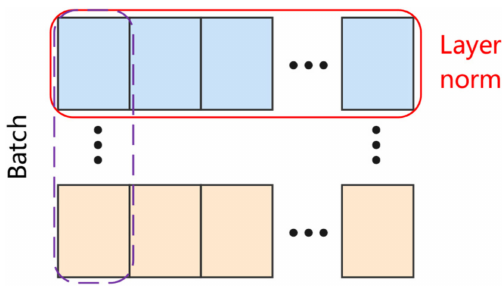
Figure 3. LayerNorm and